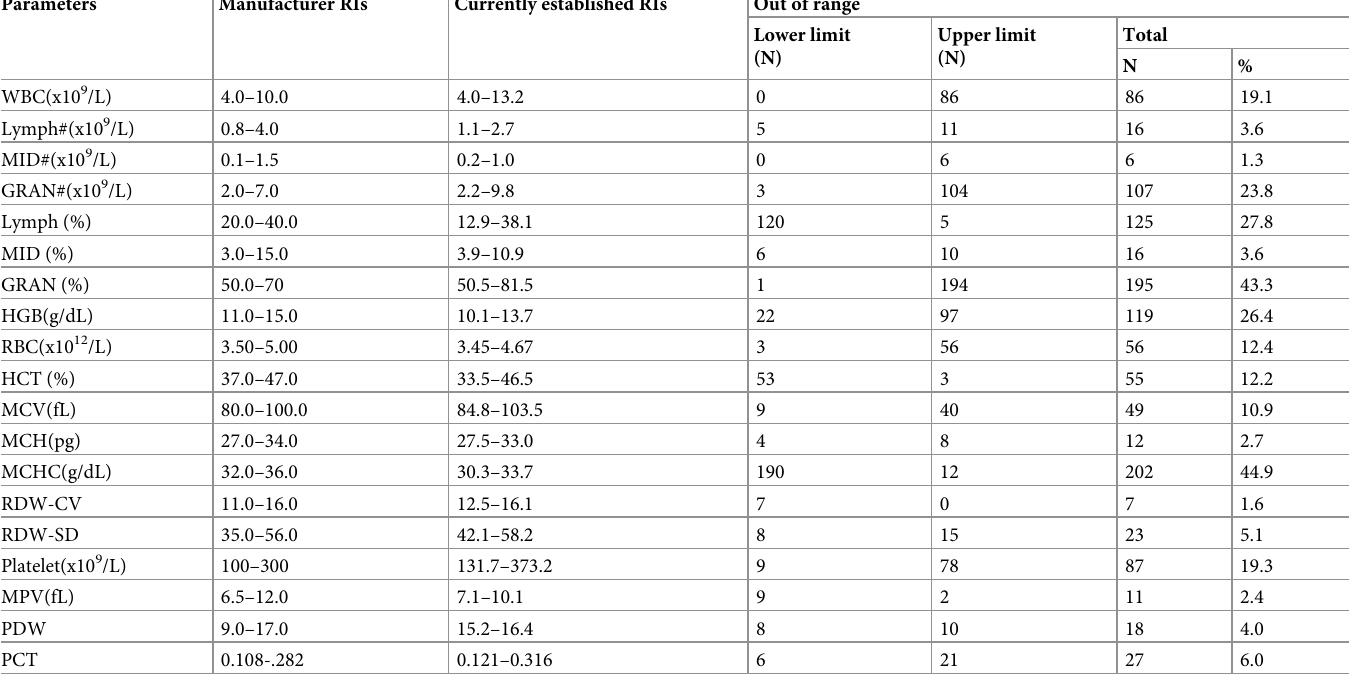
Table 4. Proportions of out of range values in pregnant women by comparison of established hematological parameters RIs with currently utilized manufacturer provided